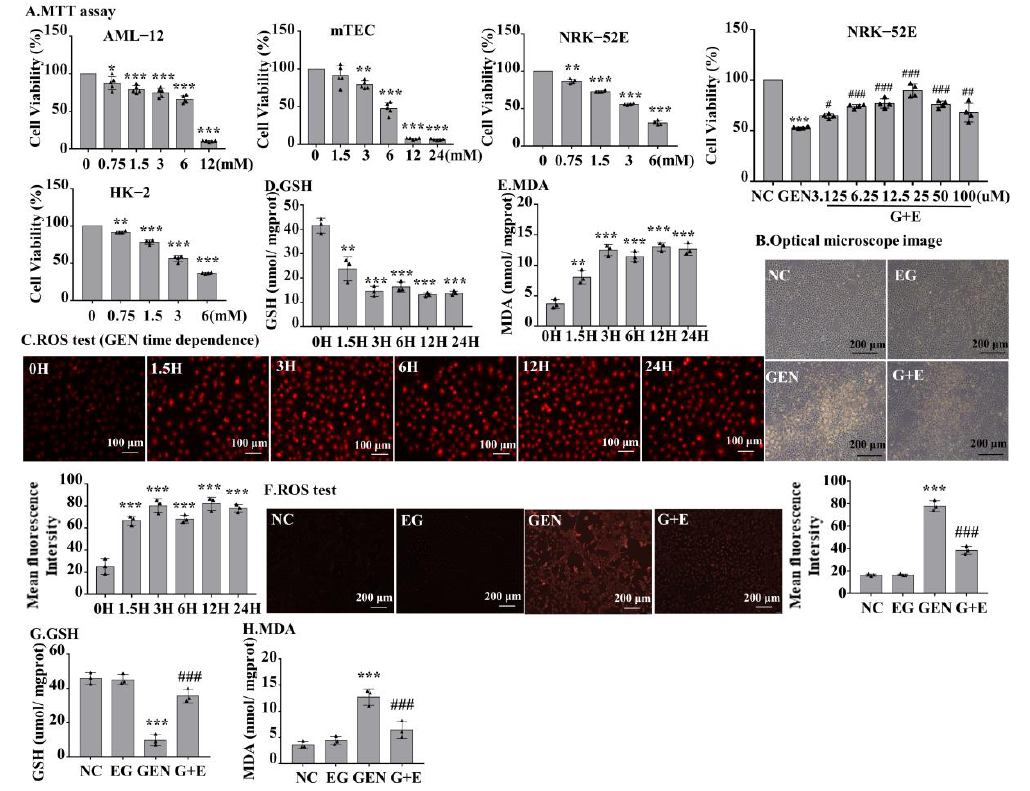
Figure 3. The effect of GEN on cell viability of different cells and the level of ROS, GSH, and MDA in normal rat kidney cell line 52E (NRK-52E) cells. ( A ) An MTT assay was used to determine the effects of GEN at different concentrations on the viability of alpha mouse liver 12, mouse renal tubular epithelial cells, NRK-52E, and human proximal tubular epithelial cell line cells. The optimal protective concentration of EG was detected by the MTT experiment. ( B ) Observed by light microscope, the damage of cells was serious in GEN (3 mM) treatment, but reduced in the EG (25 µ M) and GEN (3 mM) combined treatment groups. Scale bars = 20 0 μm. ( C ) Dihydroethidium (DHE) staining was used to detect the ROS level in NRK-52E cells. Scale bars = 100 μm. ( D ) GSH level in NRK-52E cells. ( E ) MDA level in NRK-52E cells. ( F ) DHE staining results showed that EG (25 μM) could reduce the increase of ROS in NRK-52E cells induced by GEN (3 mM). ( G ) GSH. ( H ) MDA. In vitro data was expressed as mean ± SEM of three independent experiments. * p < 0.05, ** p < 0.01, *** p < 0.001 vs. control group; # p < 0.05, ## p < 0.01, ### p < 0.001 vs. GEN group.